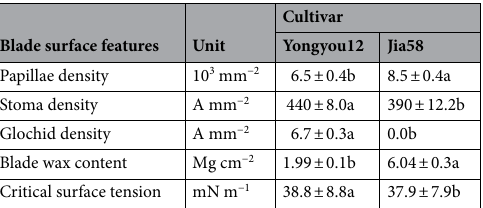
Table 3. Characteristics of leaf surface in two rice varieties. The different letters means significant difference ( P ≤ 0.01) by